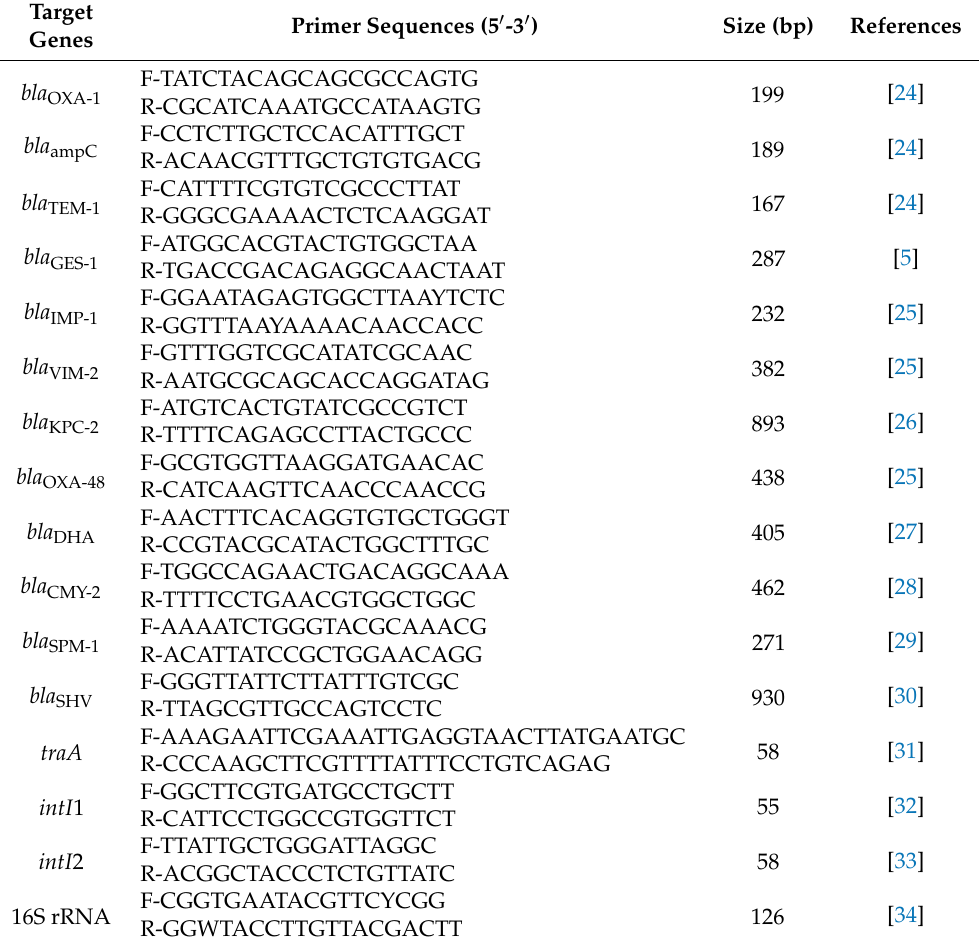
Table 1. Primer information used in this